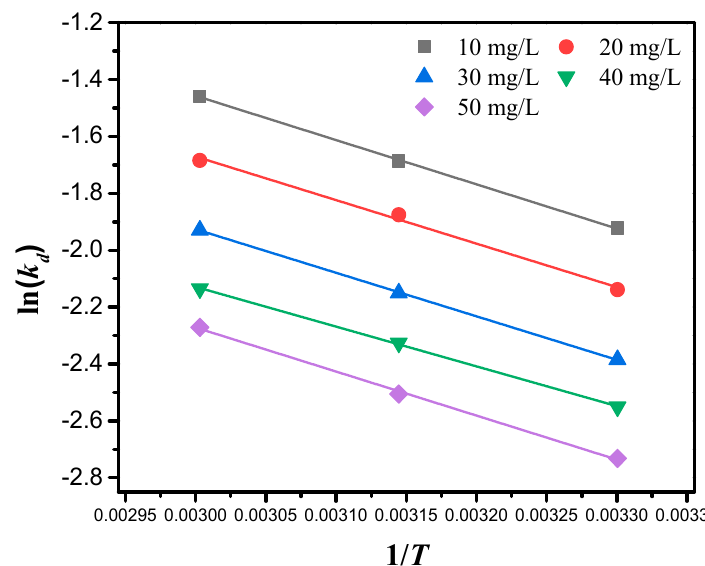
Figure 9. Plots of ln( k d ) as a function of 1/ T for different MIPMs-based adsorption systems with a series of initial clenbuterol concentrations.